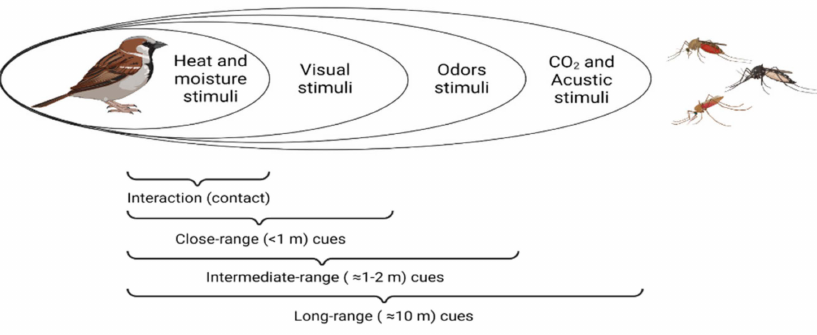
Figure 1. The sensory cues used by mosquitoes to detect their prey are distance-dependent. Mosquitoes follow a combination of cues to detect their potential hosts according to their prox- imity. Mosquitoes at larger distances can detect odours and CO 2 exhaled from host’s breath, whereas vectors use body temperature and visual stimuli to locate their hosts at closer ranges. Adapted from